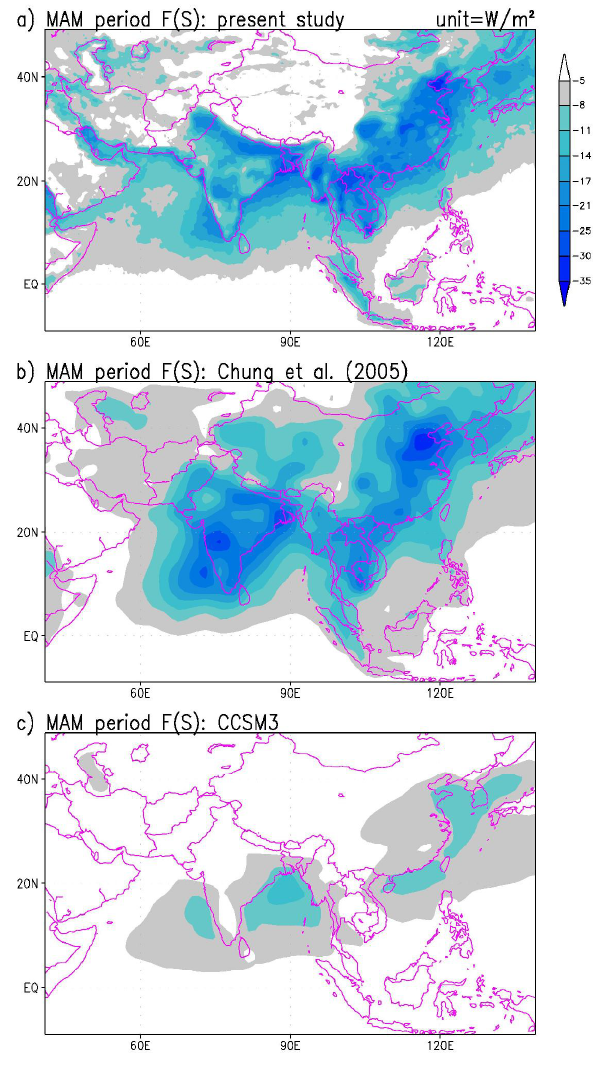
Fig. 15. Comparison of anthropogenic aerosol forcing at the sur- face: F(S), in units ofWm − 2 . (a) F(S) averaged from March to May and from 2001 to 2004 in this study. (b) MAM (March, April, May) period F(S) from Chung et al. (2005) estimate. (c) MAM pe- riod F(S) from the NCAR CCSM3.0. Shown in all the panels are average-sky aerosol forcing